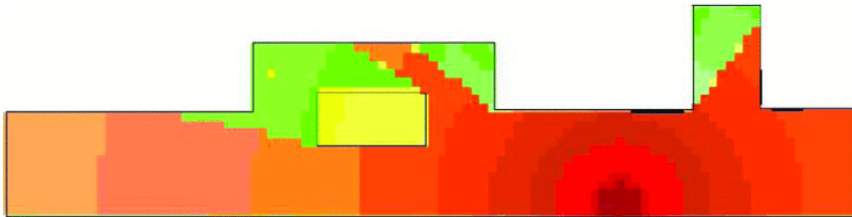
Figure 5. RFID signal propagation for antenna 2 in the corridor, taken from [11].